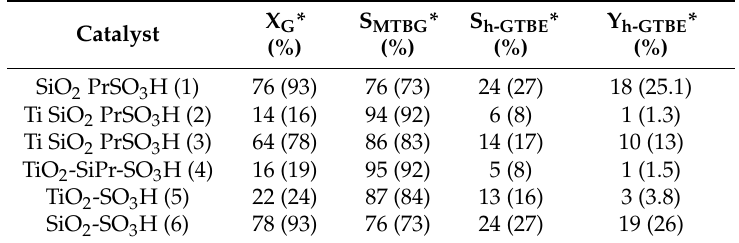
Table 2. Catalytic activity of sulfonic materials 1–6 on glycerol